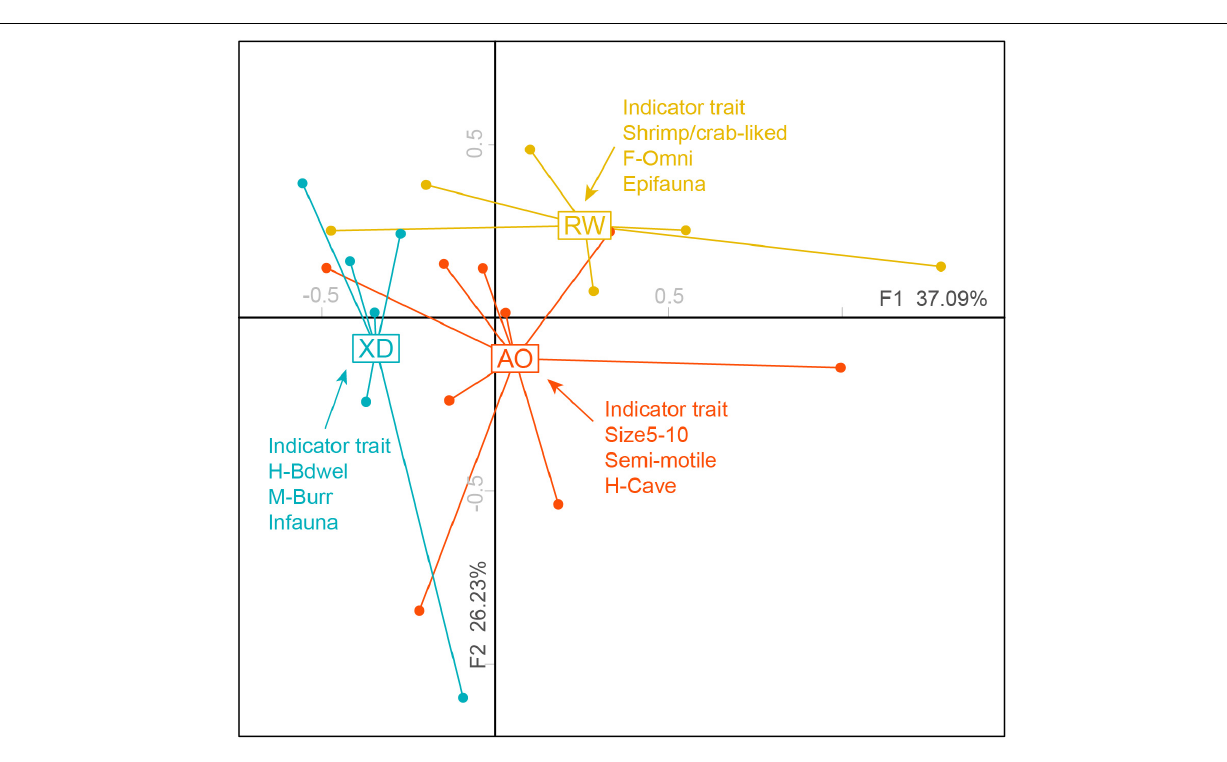
FIGURE 4 | Two-dimensional FCA plots weighted by abundance showing the distribution of sites in three intertidal zones of Laoshan Bay, and corresponding indicator trait modalities ( p < 0.05) of the three subregions. For full labels of traits modalities, see Table 1